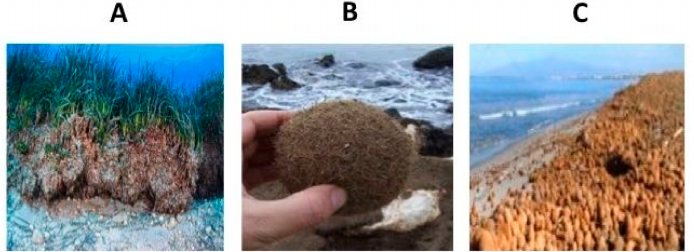
Figure 1. Posidonia oceanica rhizomes and stems ( A ) from which ball shaped dry materials called egagropili ( B ) origin and accumulate along the costal beach ( C